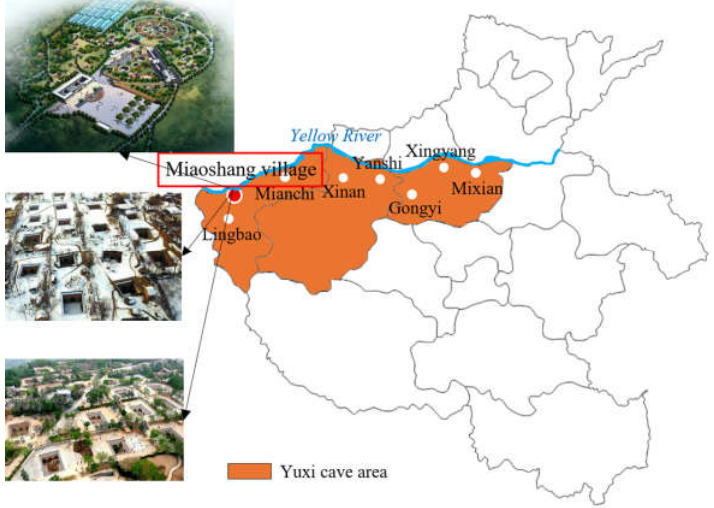
Figure 1. The distribution diagram of cave dwellings in western Henan.